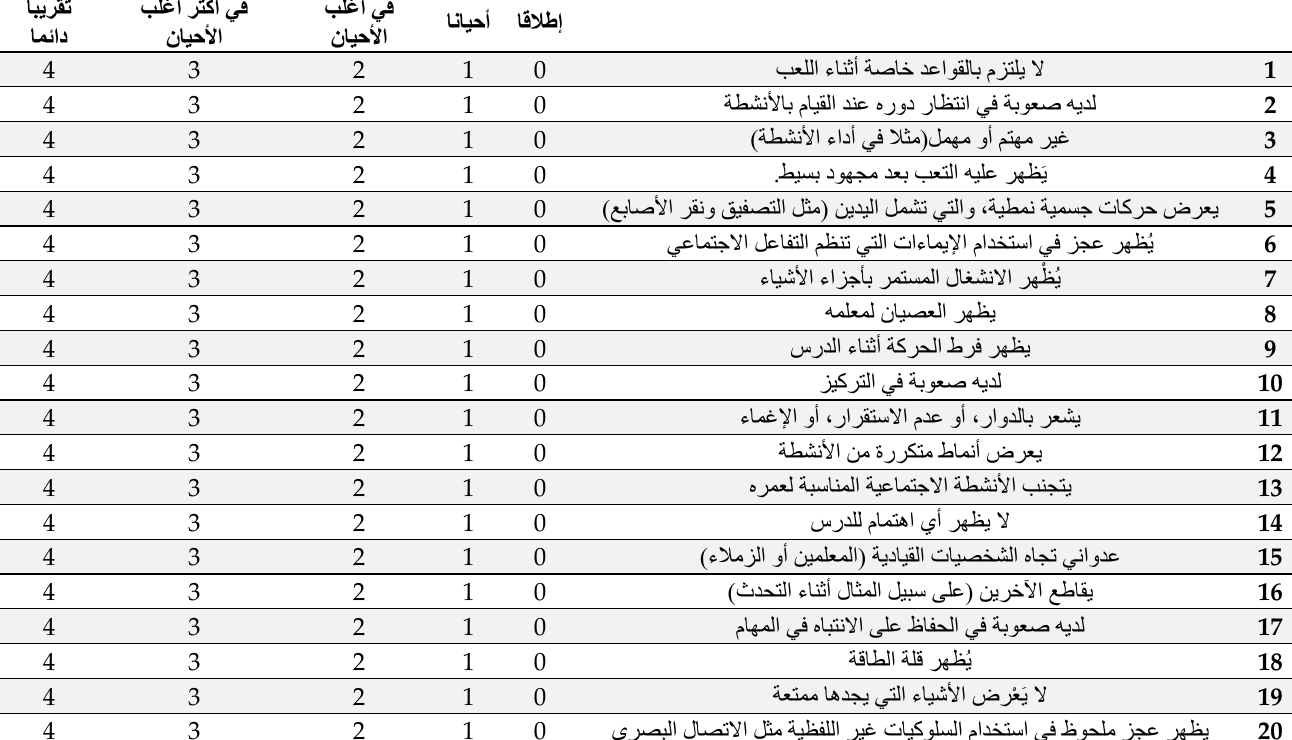
Table A1. The Arabic Version of MBC after translation and cultural